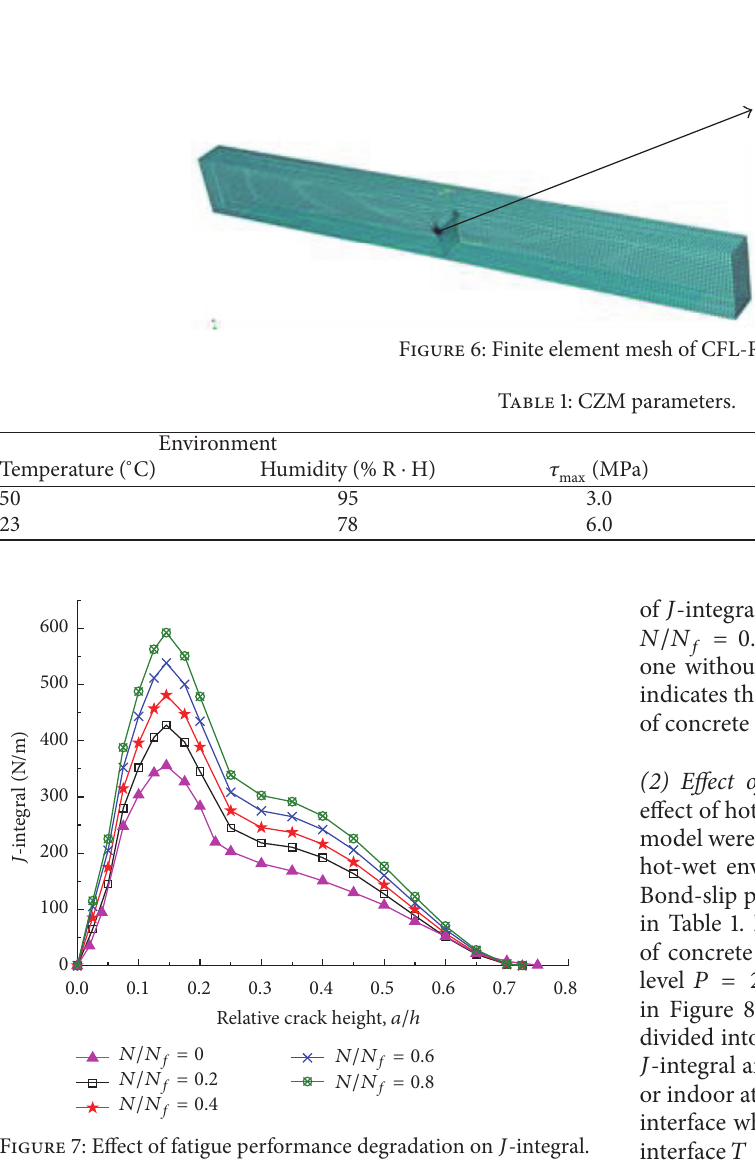
increases, and the value of 𝐽 -integral reaches the highest point at 𝑎/ℎ = 0.15 ; (2) rapid decrease stage: when relative crack height 0.15 ≤ 𝑎/ℎ ≤ 0.25 , the value of 𝐽 -integral decreases rapidly and almost linearly, and an inflection point appears at 𝑎/ℎ = 0.25 ; (3) slow decrease stage: when relative crack height 𝑎/ℎ > 0.25 , the value of 𝐽 -integral begins to decrease slowly and nonlinearly. When relative crack height 𝑎/ℎ > 0.7 , the value of 𝐽 -integral tends to be zero. The three-stage tendency coincides with our previous research [7] and achieves good agreements with fatigue crack propagation behavior observed from fatigue test in chapter